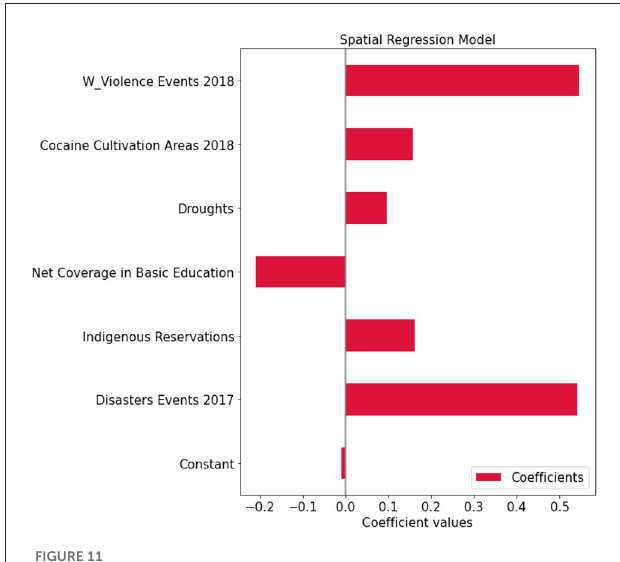
FIGURE11 Regression coefficients—analysis on Norte de